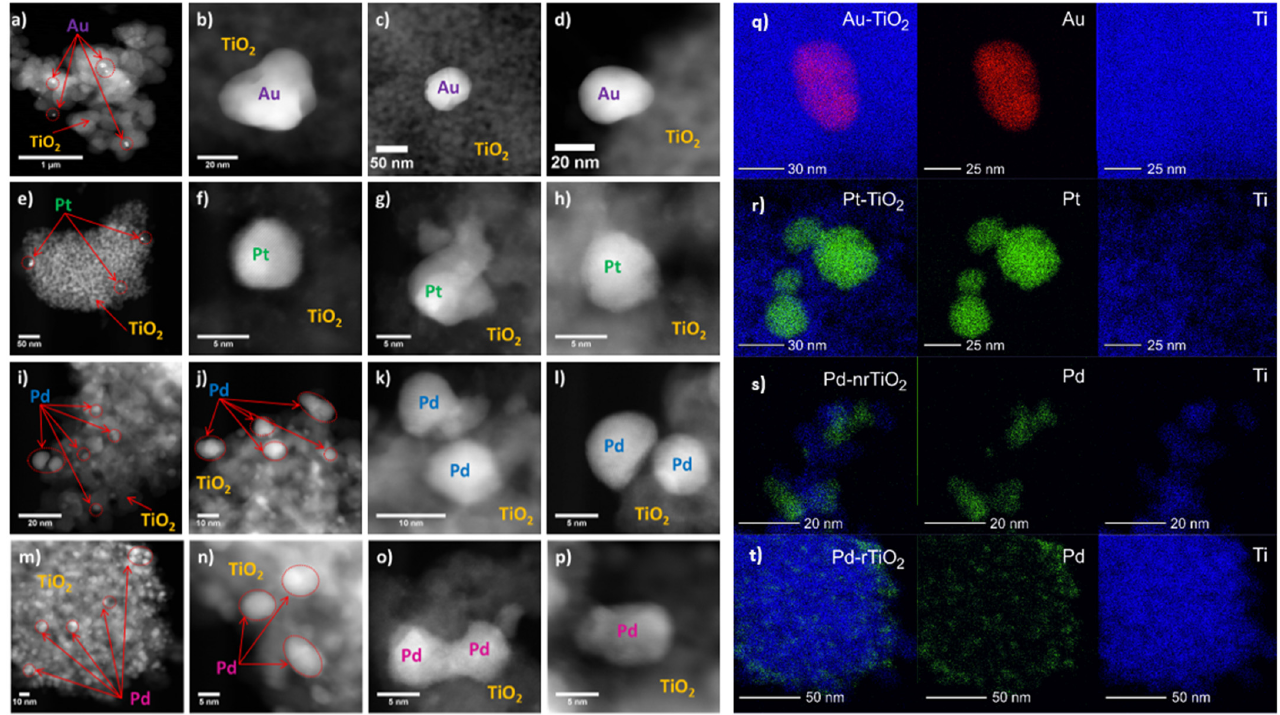
Figure 2. Left: HAADF images with 𝑧 -contrast of samples ( a – d ) Au0.5, ( e – h ) Pt0.5, ( i – l ) Pd0.5nr, ( m – p ) Pd0.5r, Right: EDS mapping of samples ( q ) Au 0.5, ( r ) Pt0.5, ( s ) Pd0.5nr, ( t ) Pd0.5r (blue is Ti, red is Au and green Pt and Pd).